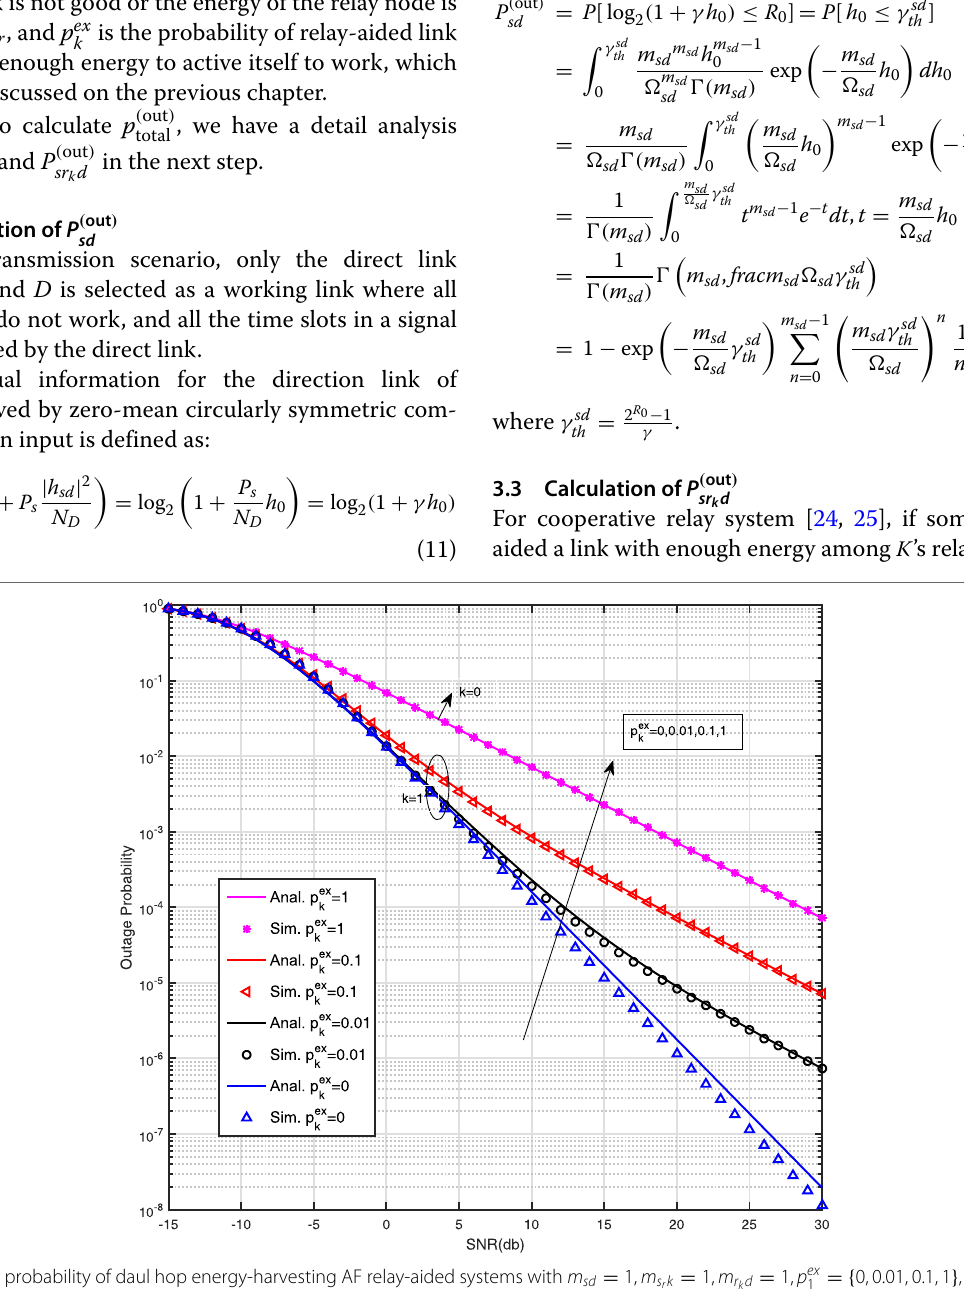
Fig. 2 Outage probability of daul hop energy-harvesting AF relay-aided systems with m sd = 1, m s